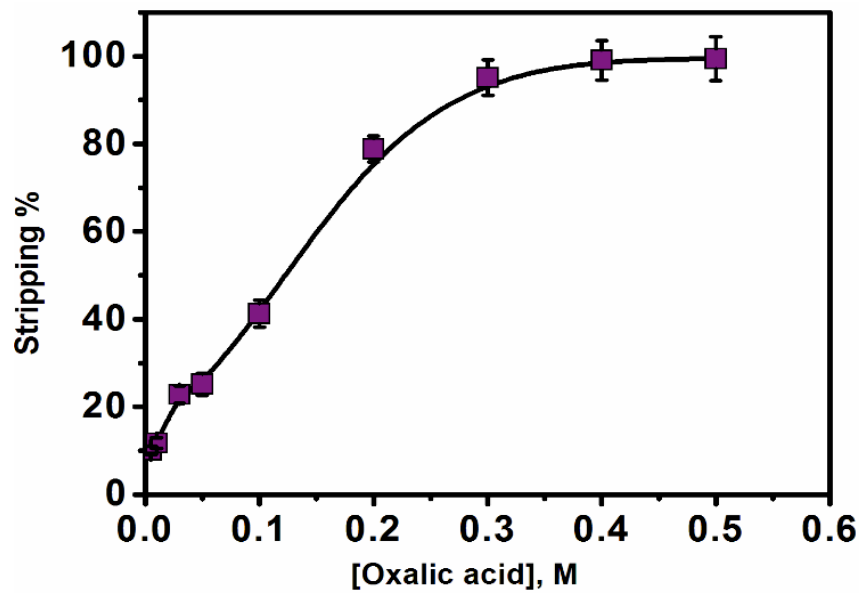
Figure 8. Stripping of loaded scandium 47 from Cyanex 272 using oxalic acid solutions.